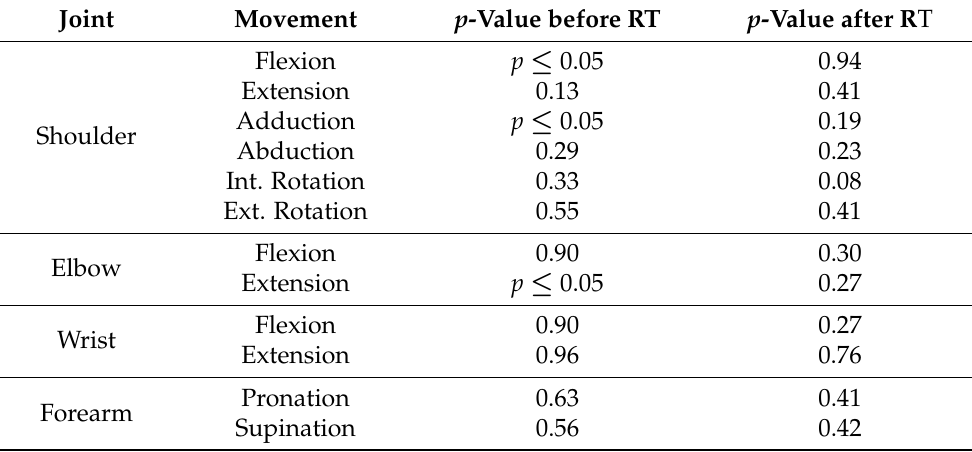
Table 3. Maximum angles Wilcoxon test of the paretic and non-paretic limb in the Maximum Forward Reach Test before and after the rehabilitation therapy.